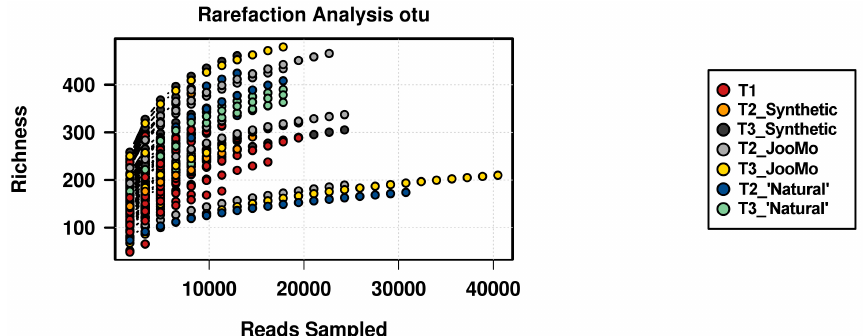
different time points of the (A) JooMo (B) synthetic and (C) ‘natural’ group samples.